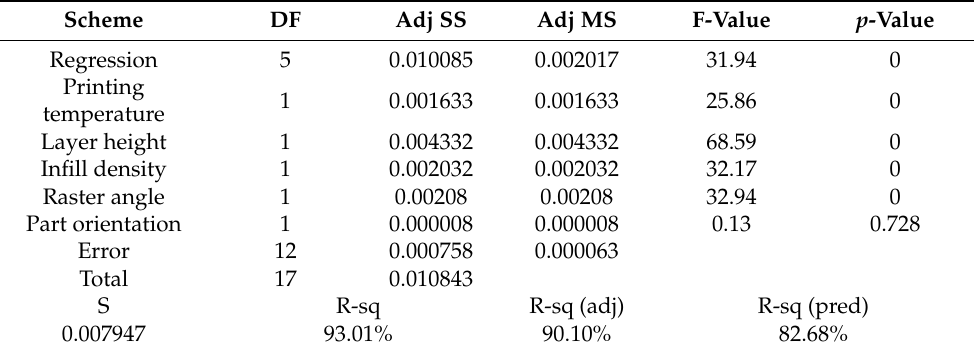
Figure 18. Optical microscopic view of the deformed specimen after impact test, side view. Table 8. Impact test response